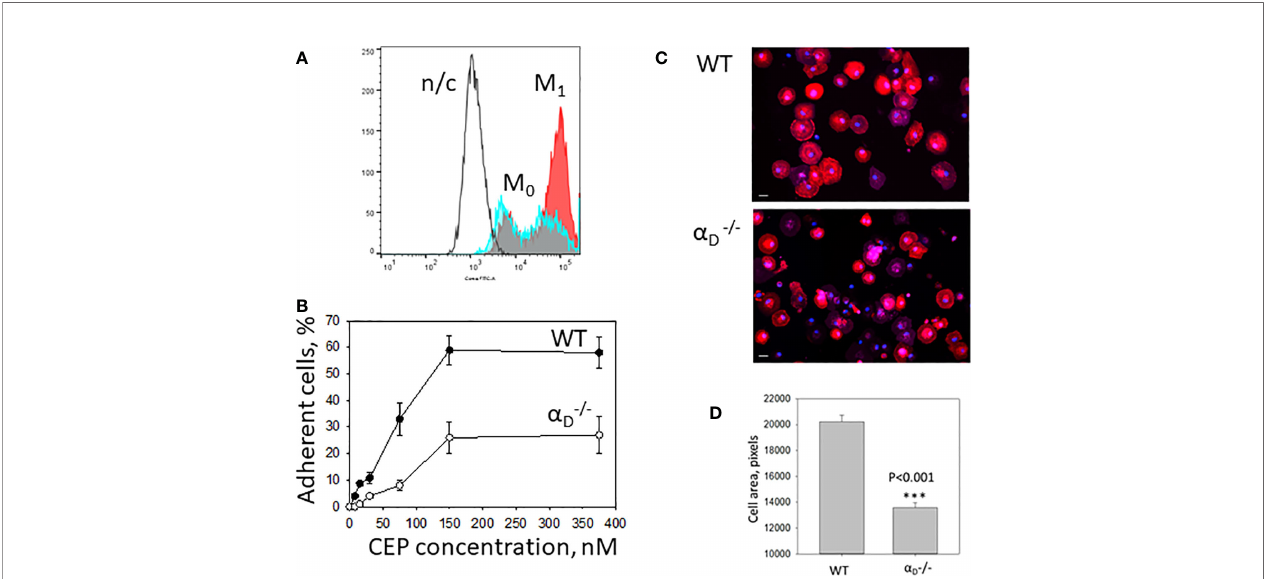
FIGURE 5 | Integrin a D b 2 is critical for M1 macrophage adhesion to CEP-modi fi ed proteins. (A) The expression of integrin a D is upregulated on M1 macrophages. Peritoneal macrophages were isolated and plated for 4 days in the presence of IFNg in complete RPMI media (Red). M1 macrophages were collected using cell dissociation buffer and stain with anti- a D polyclonal antibody, followed by staining with donkey-anti-rabbit Alexa 647secondary antibody. Freshly isolated peritoneal macrophages were used as a control (M0)(Blue). Integrin a D expression was tested using fl ow cytometry (Fortessa X-20). N/c-negative control. (B) Adhesion of WT and a − = − D M1 macrophages to CEP-BSA. Isolated M1 macrophages were fl uorescently labeled with Calcein AM and added to the well coated with CEP-BSA. cell adhesion was determined after 30 min in a fl uorescence plate reader. (C) Macrophages were allowed to adhere to glass coverslips coated with CEP-BSA for 1 hour at 37°C. After fi xation with 2% paraformaldehyde and permeabilization with 0.1% Triton X-100, cells were incubated with CytoPainet Phalloidinin-iFluor 555 and DAPI. Fluorescent images were obtained with EVOS FL auto cell fl uorescent imaging system using 20x objective with mosaic 9- fi elds setup. (D) The cell area was calculated using Imaris 8.0 software. Data are presented as mean ± SEM ***p <